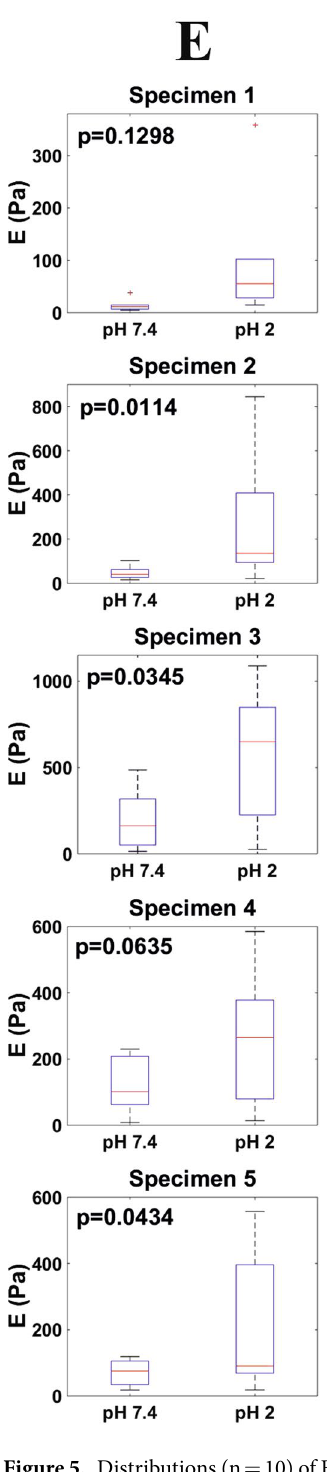
controlling the approach and separation velocities as well as the contact time. This will allow viscoelasticity stud- ies as well as a more thorough characterization of mucoadhesion processes 29, 30 . The JKR model provided a good fit to the contact region of force measurements on ileum mucosa. This allowed the estimation of its Young modulus, E. One of the main uncertainties of stiffness measurements on multi-layered samples is to determine how each of the layers contribute to the measured value. This is the case of the presented experiments as the gastrointestinal wall is made by several tissue layers, the outermost one i.e., mucosa, being covered by a mucus blanket. In this work, the Young modulus values obtained for all specimens and pH values (Fig. 5) were within the range 11–266 Pa. When it comes to biological materials, these values are significantly low